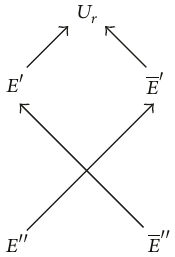
Table 2: The events and their broadcast time stamps in the